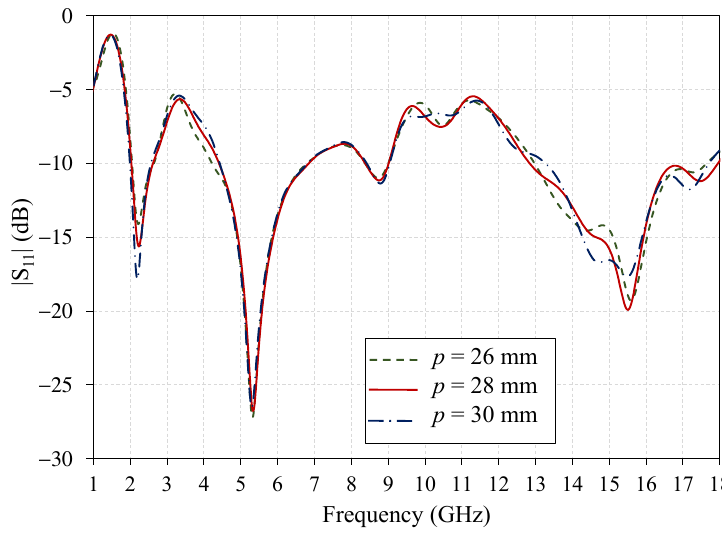
Figure 8. Simulated |S 11 | of the proposed antenna for various l 2 .